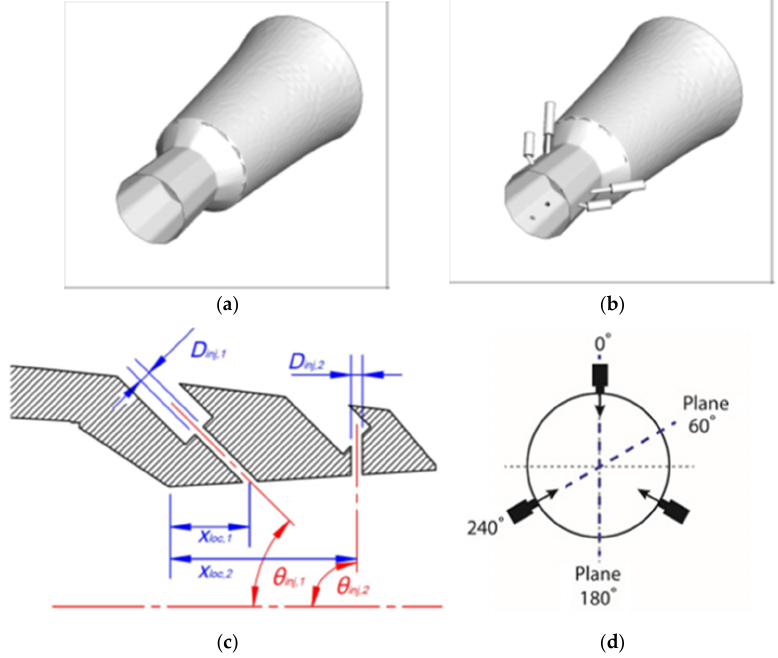
Figure 5. Details of nozzle configurations. Reprinted with permission from ref. [64]. Copyright 2020